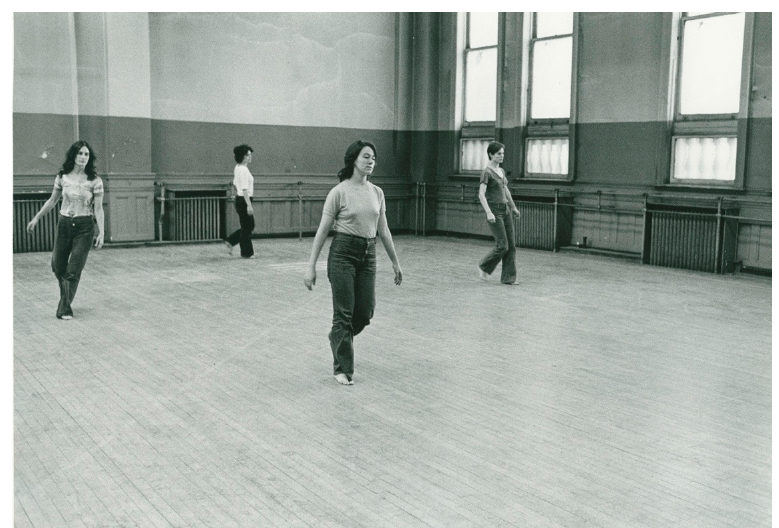
Figure 1. Babette Mangolte, Calico Mingling (1973), with Susan Brody, Lucinda Childs, Janice Paul, and Judy Padow at The Judson Memorial Church, New York, gelatine silver print, 7.8” × 9.9”, Fonds Lucinda Childs—Médiathèque du Centre national de la danse © 1973 Babette Mangolte, all rights of reproduction reserved.